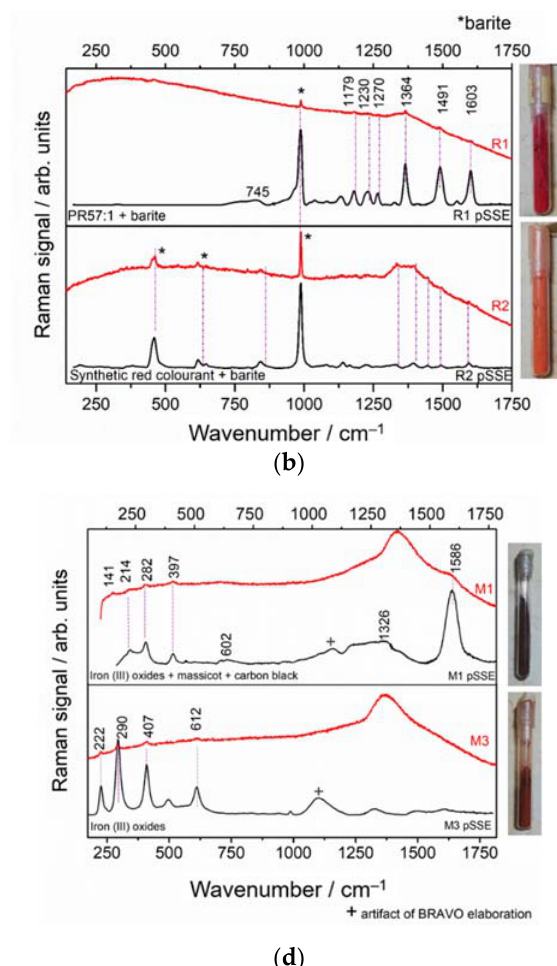
red colorants and iron (III) oxides. In R1 (Figure 7b), the bands of the